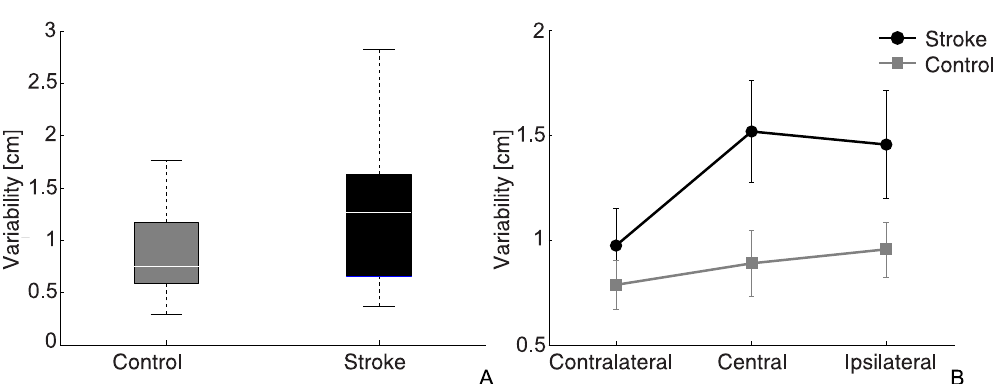
Fig 4. Variability. (A) Box-plot of variabilityfor the two groups. (B) Mean variabilityin the 3 directionsfor the two groups, where the gray squaresrepresentsdata from the control group and black circles represent stroke patients.